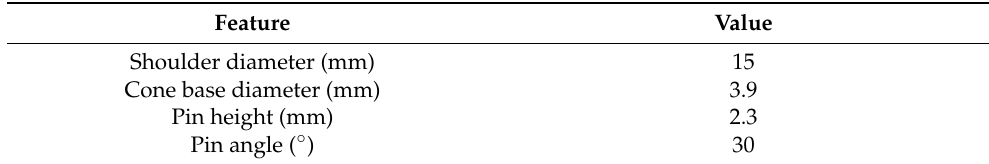
Figure 2. Details of the FSW process: ( a ) schematic representation of the FSW process; geometric features of the conical pin tool in the H13 tool steel used in the FSW experiments and welding process parameters; and ( b ) picture of one of the welded parts, representative of all the processing conditions used. Table 2. Features of the FSW system reported in Figure 1.